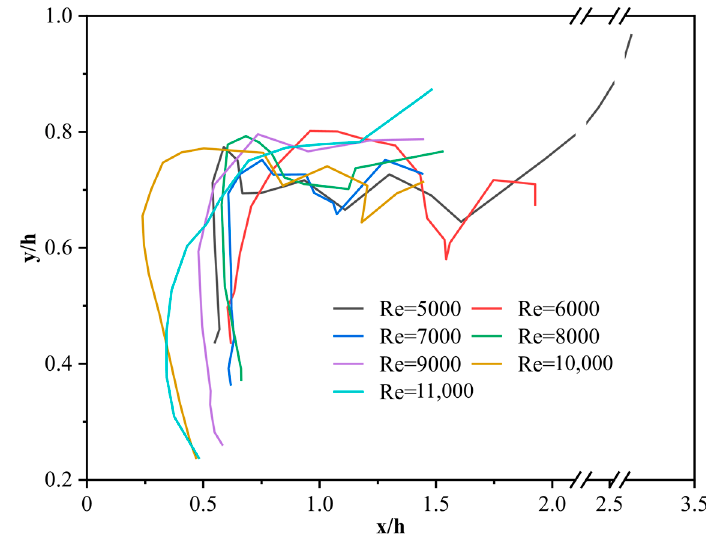
Figure 21. Motion trajectory diagram after the bubble is separated.